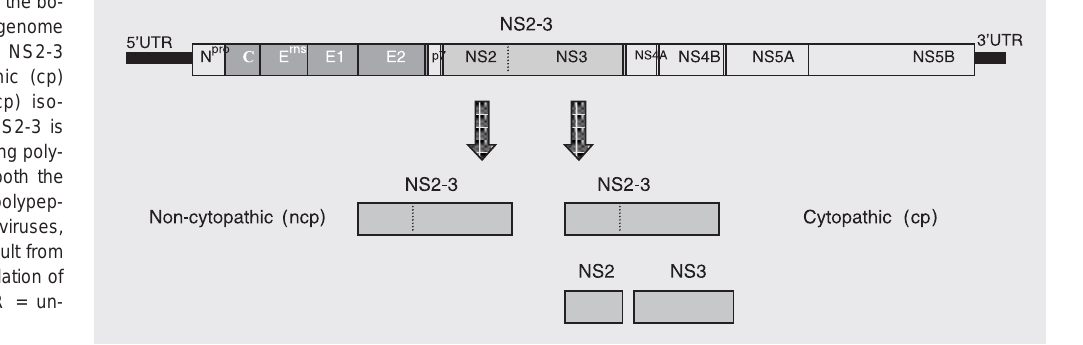
Figure 1. Organization of the bo- vine viral diarrhea virus genome and processing of the NS2-3 polypeptide in cytopathic (cp) and non-cytopathic (ncp) iso- lates. In ncp isolates, NS2-3 is expressed as a single-long poly- peptide; in cp isolates both the entire NS2-3 and NS3 polypep- tides are found. In cp viruses, NS3 expression may result from NS2-3 cleavage or translation of a duplicated gene. UTR = un- translated